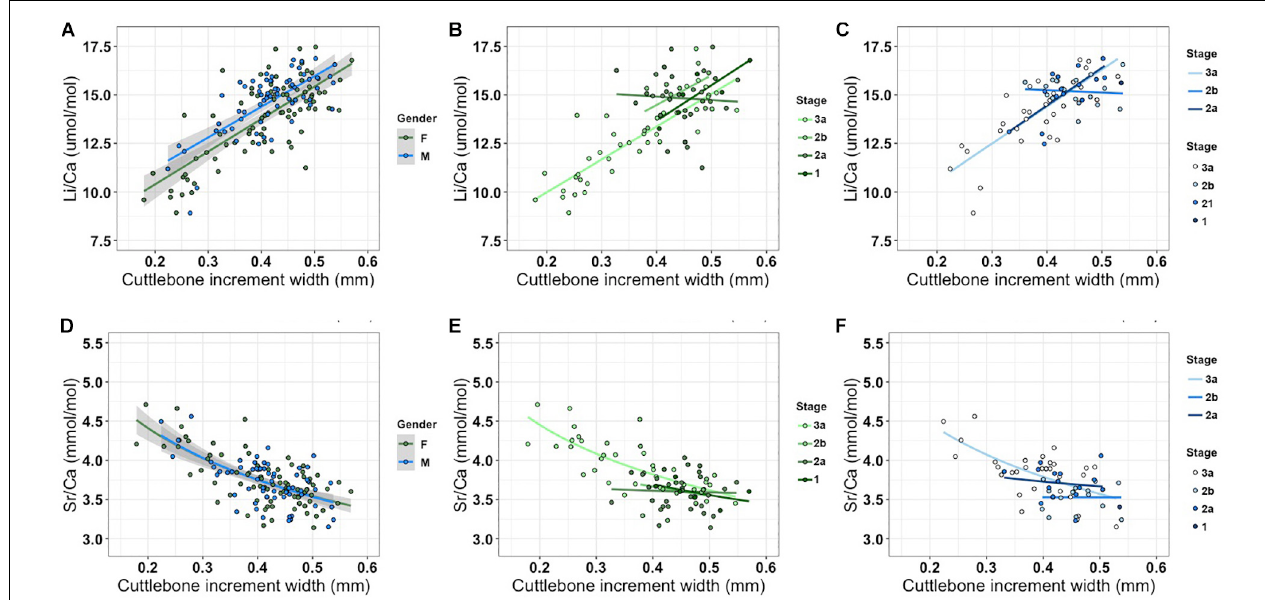
FIGURE 3 | Relationship between temperature-corrected Li/Ca (A–C) and Sr/Ca (D–F) and the width of last increment in cuttlebone. Increment width refers to the growth rate in wild cuttlefish. Comparisons among maturity stages are given for females (B,E) and males (C,F) . Results of multiple linear regression are presented in Table 4 (1, immature; 2a, developing; 2b, maturing; and 3a, mature).